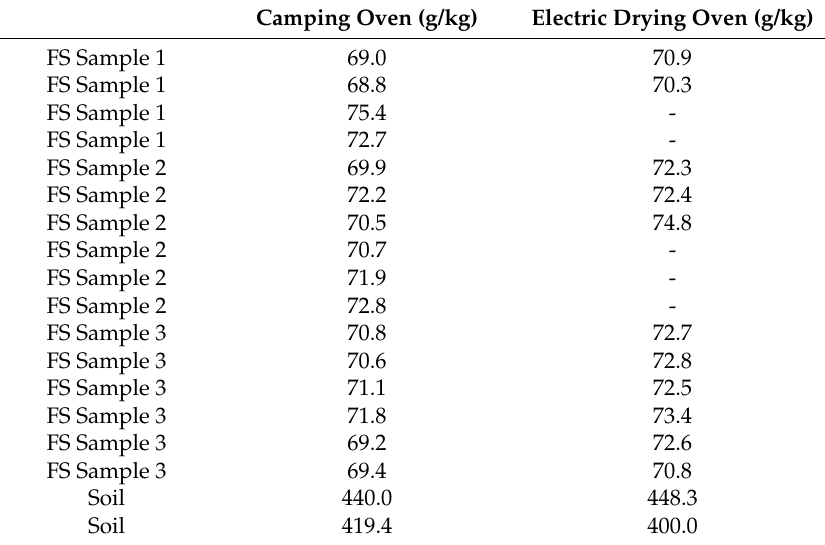
Table A10. Raw data of the total solid determination experiments.